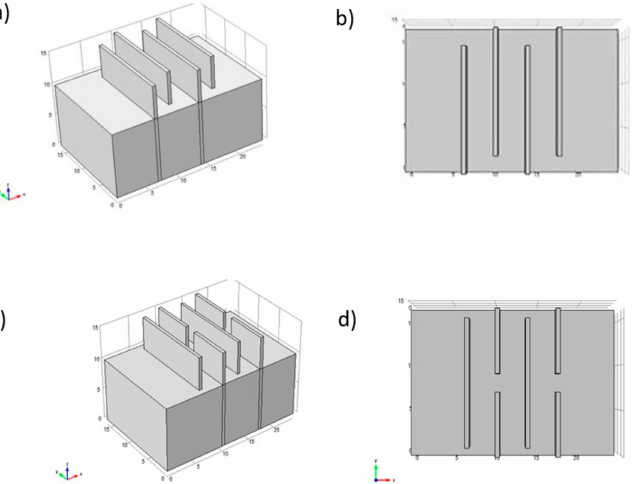
Figure 13. Diagram of three-dimensional configuration and cross-sections: ( a ) typical configuration; ( b ) X-Y cross section; ( c ) new configuration; ( d ) X-Y cross section (adapted from Song et al. [24]).